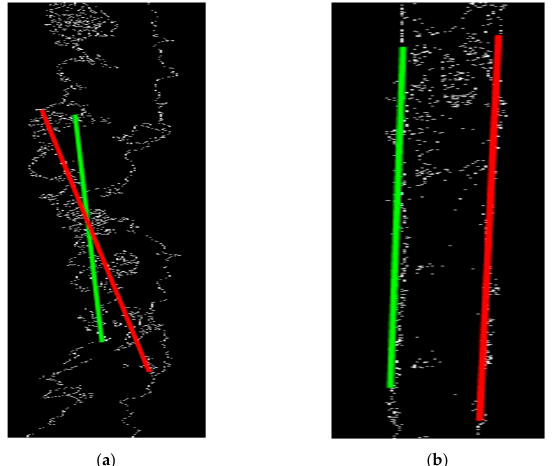
Figure 16. ( a ) Non-dangerous crack detection results. ( b ) Non-dangerous crack-hunting result.